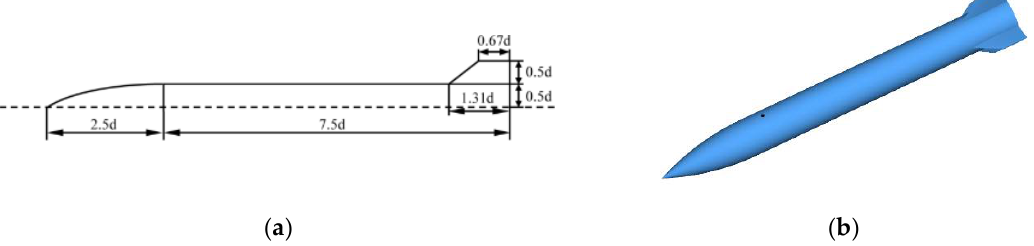
Figure 2. This AFF body-fin configuration: ( a ) Geometric parameters; ( b ) 3D model.